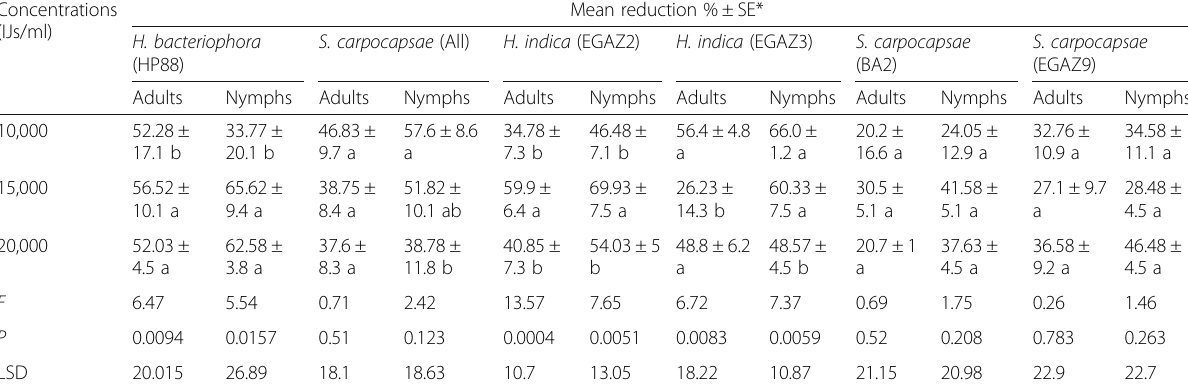
Table 2 Mean reduction (%) of life stages of onion thrips as induced by six different entomopathogenic nematode isolates (EPNs) at different concentrations Concentrations (IJs/ml)